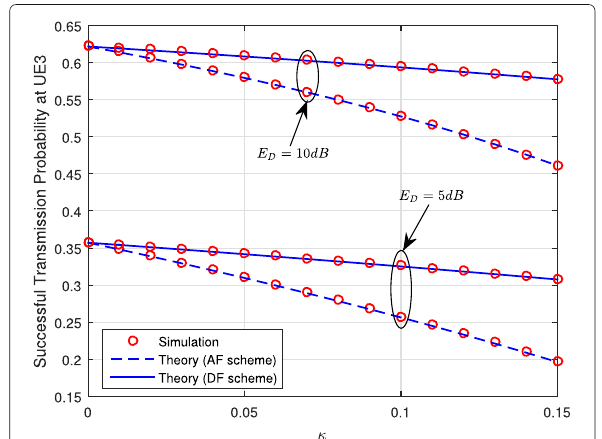
Fig. 5 STP versus HWIs level, κ with E D = 10 dB or E D = 5 dB at UE3